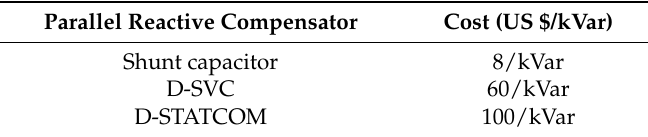
Table 2. Costs of different reactive power